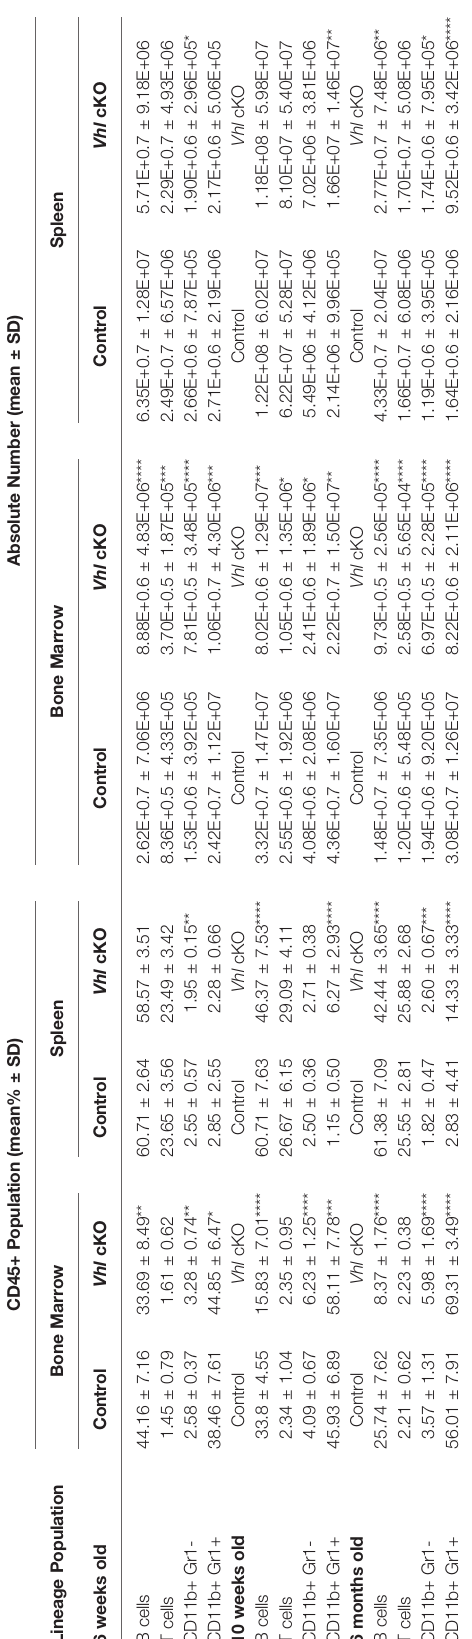
A through Fraction F in both frequency and absolute numbers ( Figures 4E, F ), extending the defect to include Fraction A as ( Figure 3 ). In contrast, overall hematopoiesis, including B cell development, was normal in the Vhl cKO ! WT chimeras ( Supplementary Figure 2 ). Since Vhl deletion in B cells